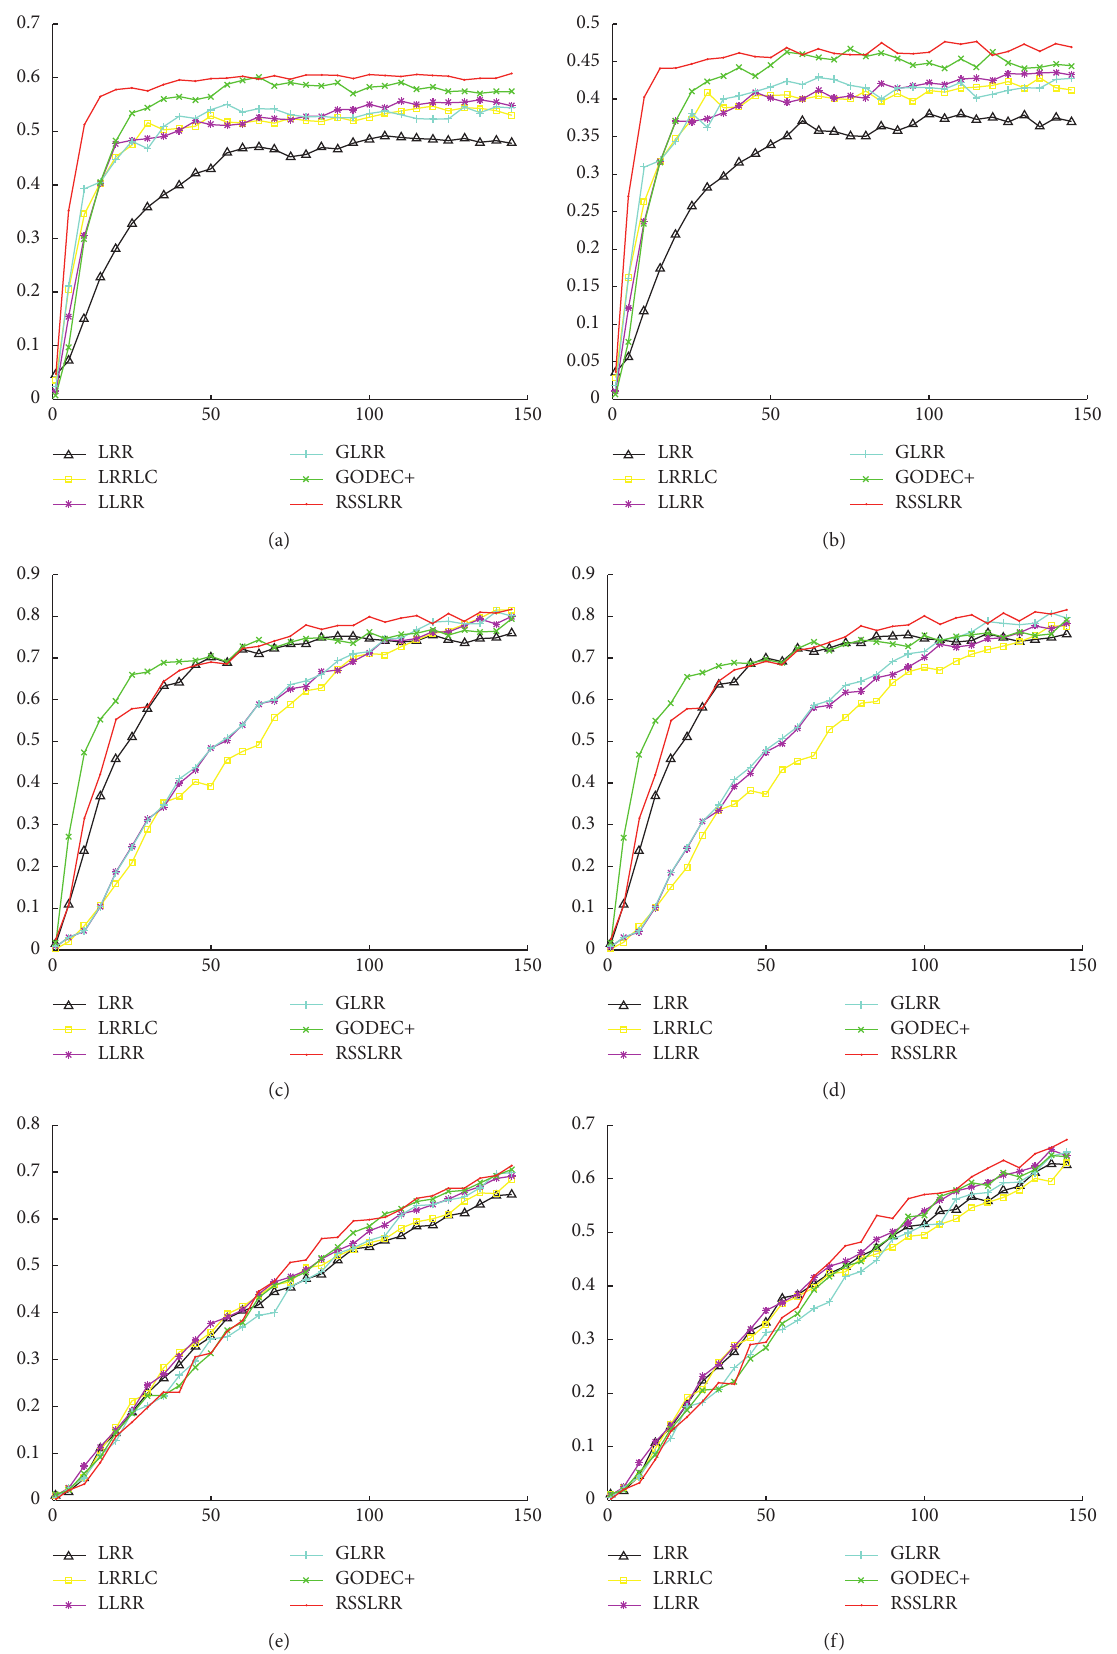
Figure 6: Variations of classification accuracies with increasing feature dimensionalities of 6 × 6 and 8 × 8 occlusions on (a, b) ORL, (c, d) CMU PIE, and (e, f) COIL20